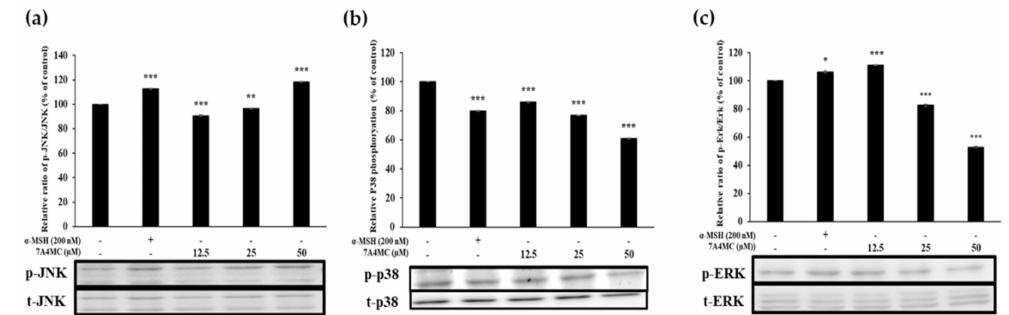
Figure 7. E ff ect of 7A4MC on the phosphorylation of p-JNK, p-p38, p-ERK. B16F10 cells were treated with 7A4MC at di ff erent concentrations for 4 h. ( a ) Results of Western blot and protein level of p-JNK, ( b ) p-p38, and ( c ) p-ERK. Results are expressed as a percentage of the control. The data represent the mean ± SD of triplicate experiments. * p < 0.05, ** p < 0.01, *** p < 0.005. p: Phosphorylated, t: